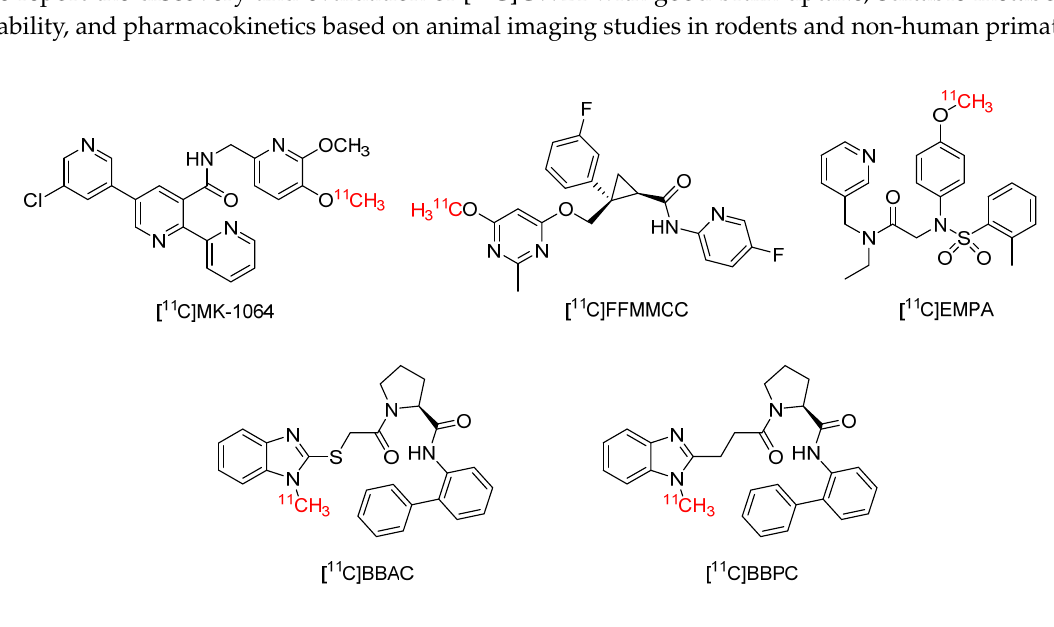
Figure 1. structures of orexin receptor radioligands. Figure 1. Structures of orexin receptor